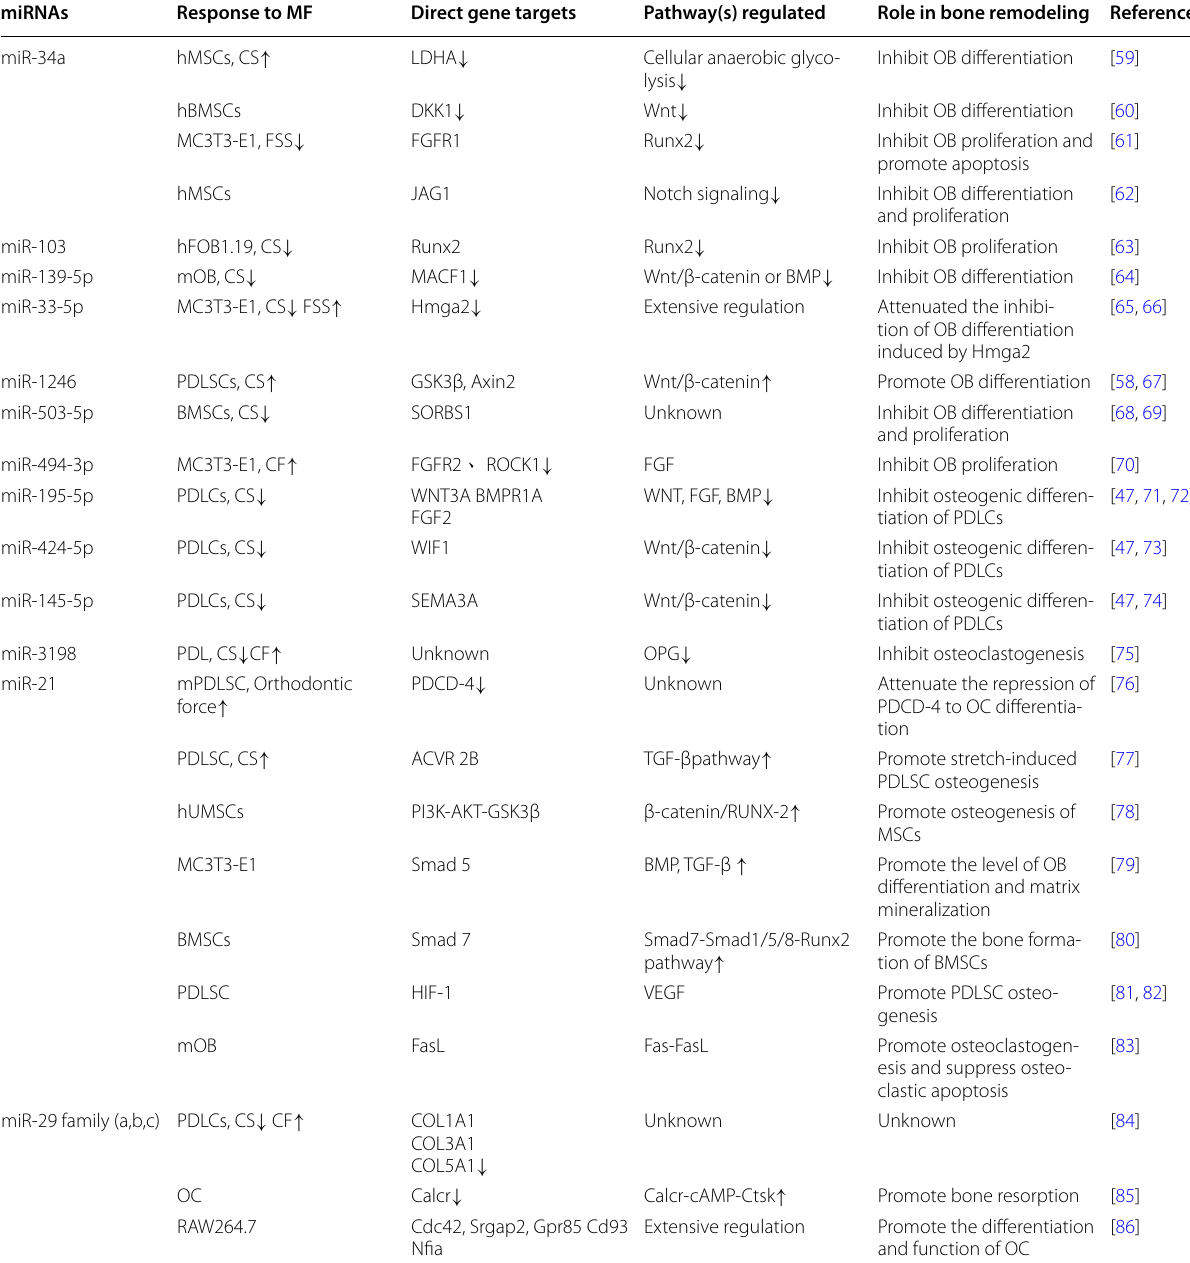
Table 1 Role of mechanical force microRNAs in bone